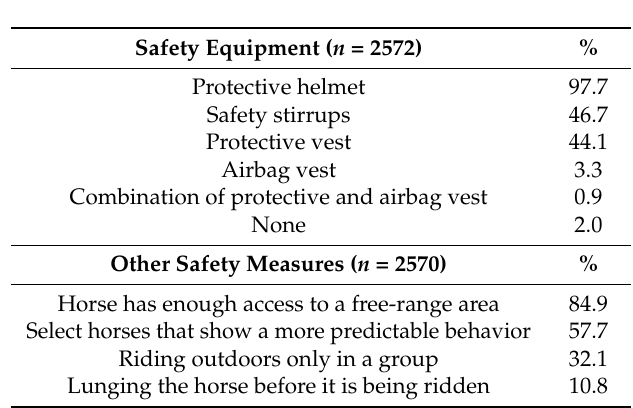
Table 3. Possession of safety gear and other safety measures.